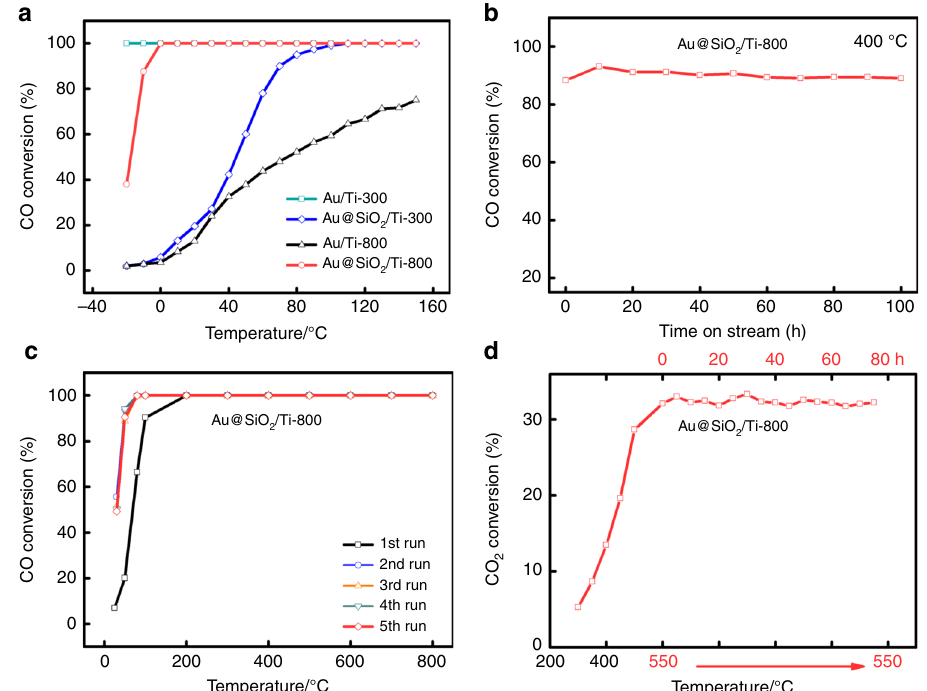
Fig. 5 The catalytic performance of gold catalysts in various reactions. a CO conversion as a function of reaction temperature on Au/Ti-T and Au@SiO 2 / Ti-T; b CO conversion as a function of reaction time on Au@SiO 2 /Ti-800 catalyst tested at 400 °C; c CO conversion as a function of reaction temperature on Au@SiO 2 /Ti-800 catalyst for different cycles. Gas fl ow: 1 vol.% CO + 20 vol.% O 2 + 79 vol.% N 2 , and the space velocity for a , b , and c is 20L g cat. − 1 h − 1 , 1005L g cat. − 1 h − 1 and 60 Lg cat. − 1 h − 1 , respectively. d The catalytic performance for RWGS reaction on Au@SiO 2 /Ti-800. Gas fl ow: 10 vol.% CO 2 + 90 vol.% H 2 , and the space velocity is 15L g cat. − 1 h − 1